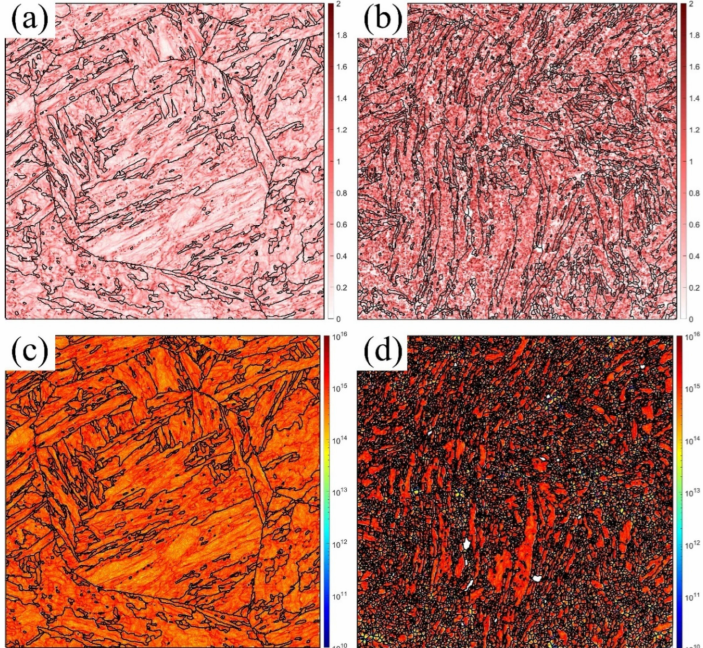
Figure 9. KAM and GND maps for the medium ( a , c ), and maximum ( b , d ) degrees of deformation at RT.